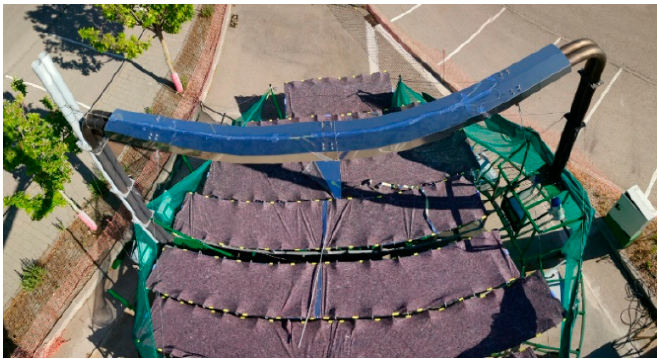
Figure 22. Solar field top view, covered to avoid unwanted effects. Table 4. Mechanical costs excluding the platform base and traction system.